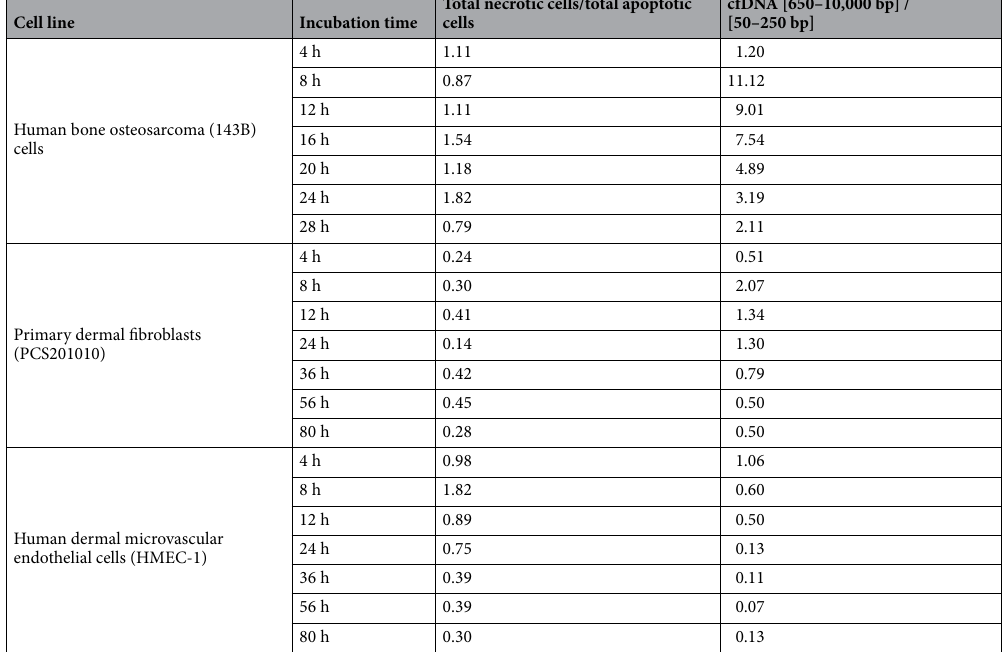
Table 4. The relationship between the total number of necrotic vs apoptotic cells over increasing incubation periods in three cell lines, as determined by a caspase-3/7 assay, and the relationship between the concentration of 650–10,000 bp cfDNA fragments vs 50–250 bp cfDNA fragments at corresponding time- points, as determined by a capillary electrophoresis